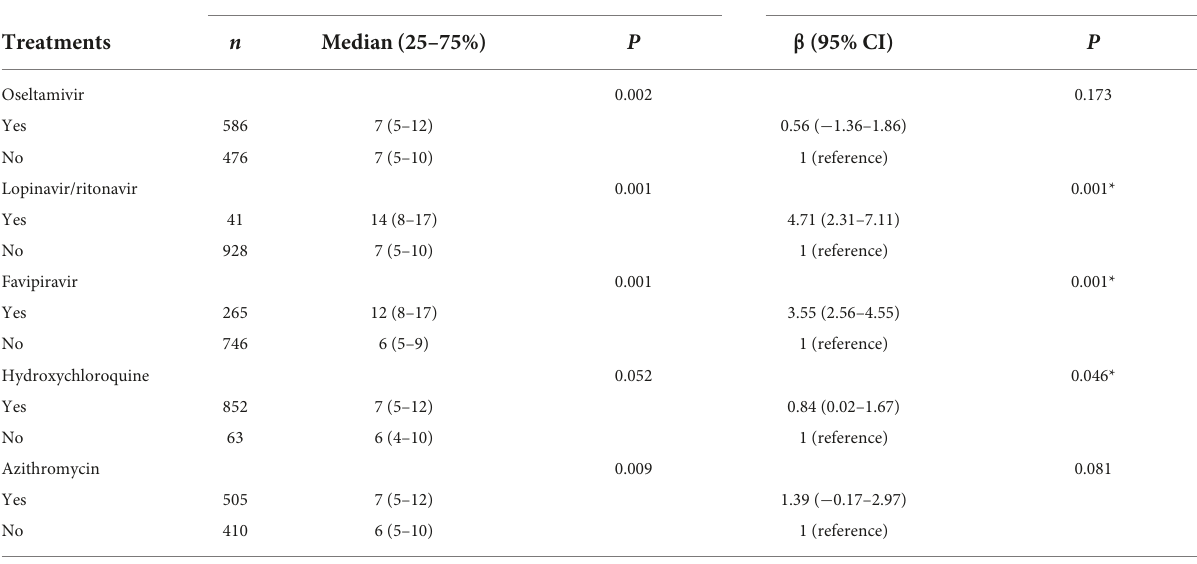
TABLE 2 The association between use of treatment drugs and the duration of hospital stay. Length of hospital stay Univariate analysis Generalized linear regression analyses*